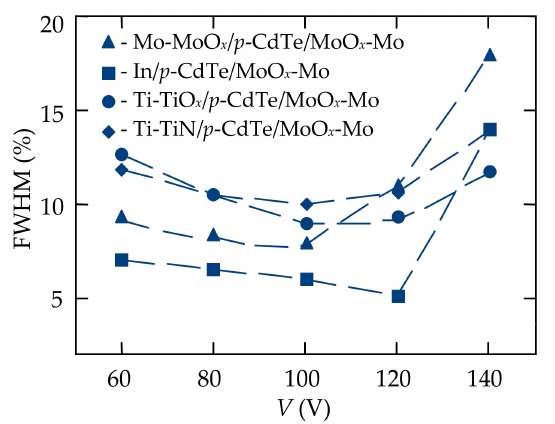
Figure 11. Effect of the bias voltage applied to the Mo-MoO x / p -CdTe/MoO x -Mo (triangles), In/ p - CdTe/MoO x -Mo (squares), Ti-TiO x / p -CdTe/MoO x -Mo (circles), and Ti-TiN/ p -CdTe/MoO x -Mo (diamonds) Schottky-diode detectors on the energy resolution (FWHM) of the 662 keV photopeak in the room temperature 137 Cs isotope spectra.